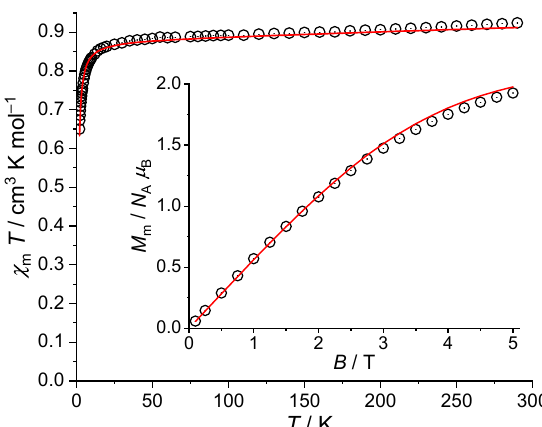
Figure 7. Temperature dependence of χ m T at 0.1T, and molar magnetization M m vs. magnetic field B at 2.0K (inset) of 2b (symbols: experimental data, red line: least-squares fit to an isotropic effective spin Hamiltonian).